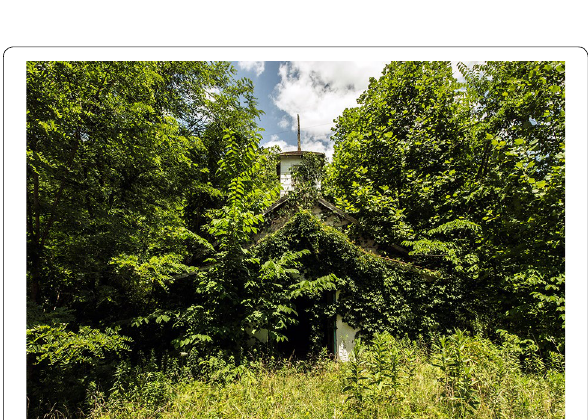
Fig. 5 Raised relief map of West Virginia